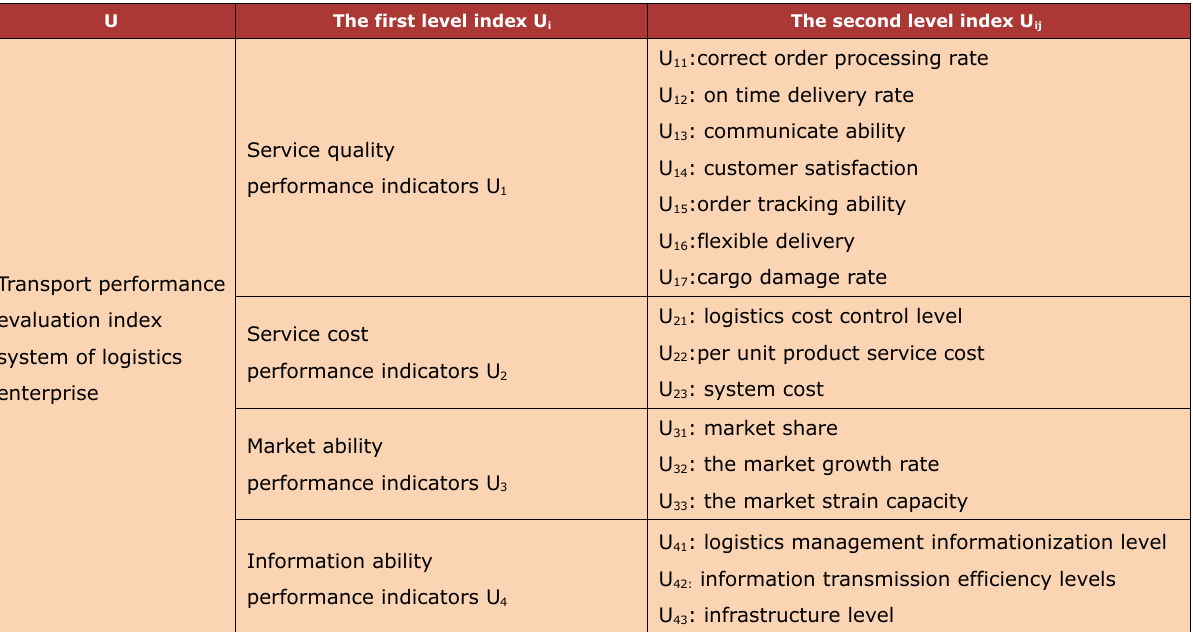
Table 1. Transport performance evaluation index system of logistics